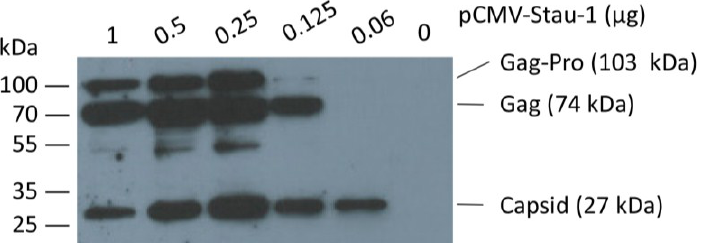
Figure 4. Co-expression of the human Staufen-1 protein enhances oriHERV-K113 protein production. Western blot detection by using a Gag (CA)-specific antiserum of intracellular HERV Gag protein 48 h after co-transfection of HEK 293T cells with a fixed amount of oriHERV-K113 full-length molecular clone and decreasing amounts of the Staufen-1 expression vector. The presumed Gag-Pro, Gag and processed capsid proteins are indicated. The exposure time was optimized to show expression differences. It was too short to visualize Gag proteins on lane 6 (no Staufen-1